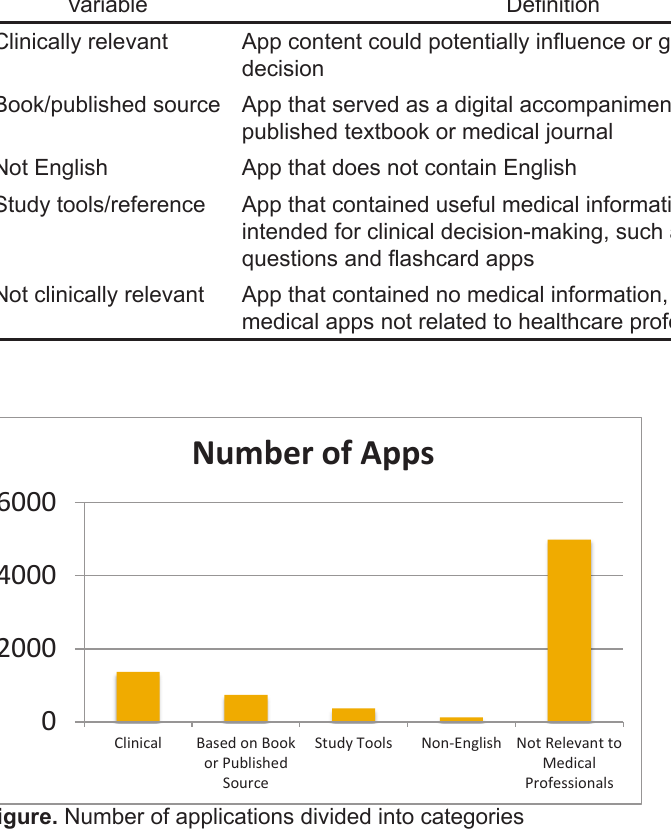
providers will have difficulty in identifying clinically relevant